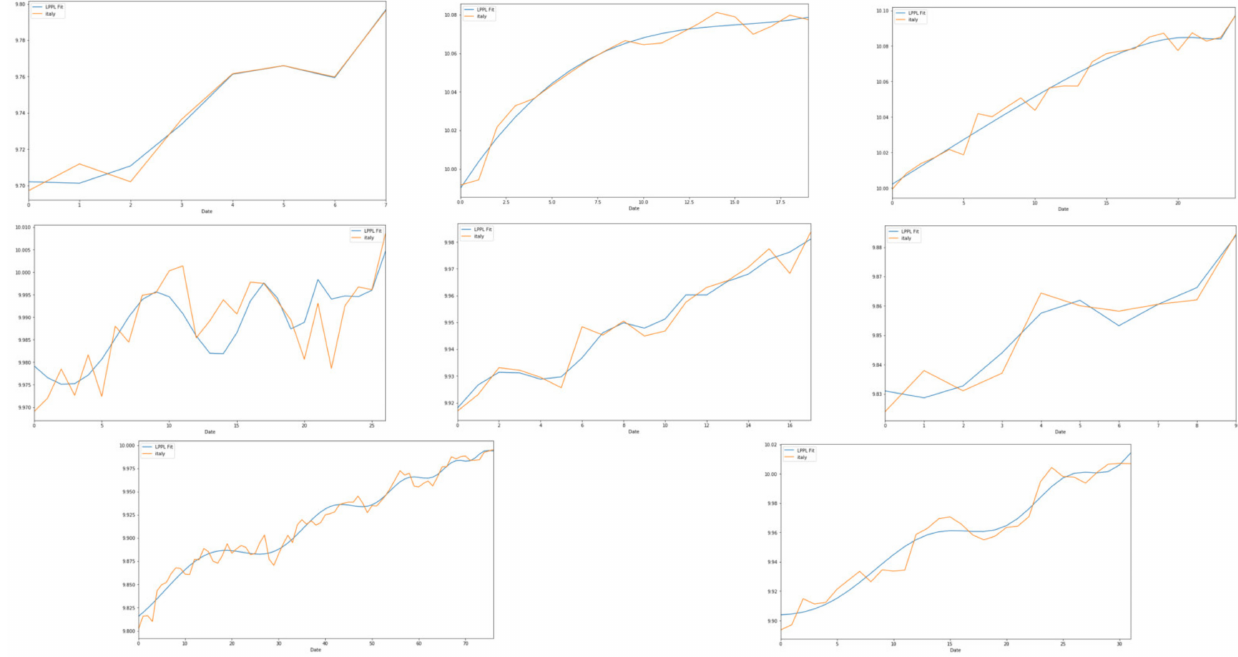
Figure A2. LPPL Signatures in the Italian Stock Exchange (FTSE MIB) 15 January 2015 to 30 December 2019. Log-periodic power law signatures in the Italian Stock Exchange.